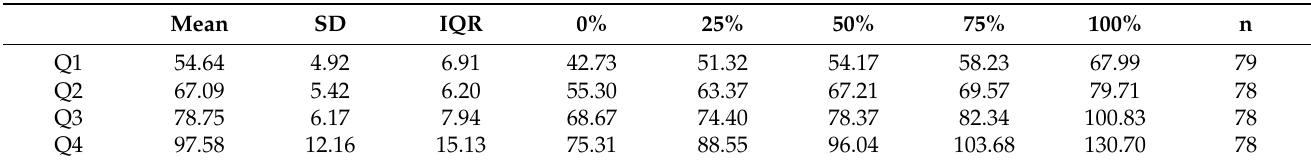
Table 7. Dependency Index (ratio of the population under 15 years of age to the population over 64 years of age). Sources: own elaboration based on data from the Galician Institute of Statistics (IGE), Municipal Register of Inhabitants, the year 2021.